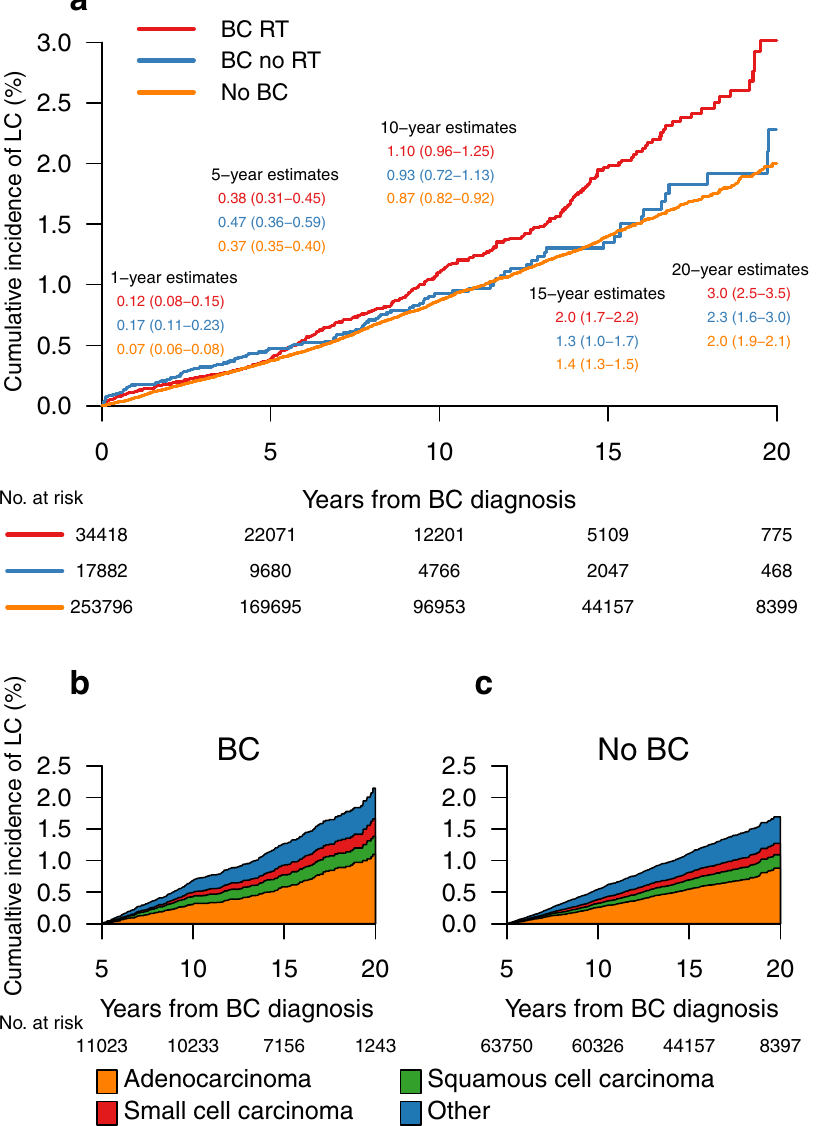
Fig. 1 Cumulative incidence of lung cancer. Cumulative incidence of lung cancer (LC) for women without breast cancer (BC) diagnosis, women with BC not receiving radiotherapy (RT), and women with BC receiving RT ( a ). The distribution of the different LC histological subtypes for women with follow-up of longer than fi ve years is displayed in ( b ) for women with BC, and in ( c ) for women without BC diagnosis. Number